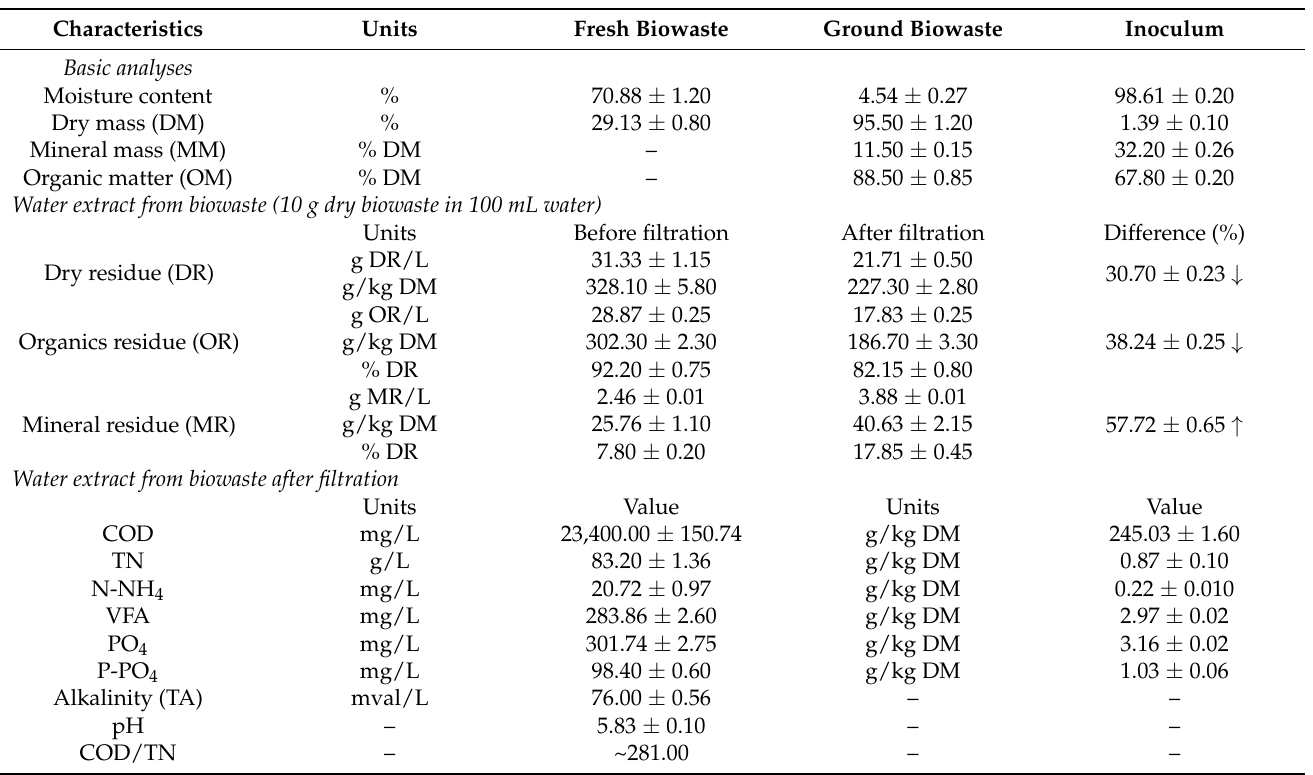
Table 1. The characteristics of biowaste and the inoculum used in the measurements of methane